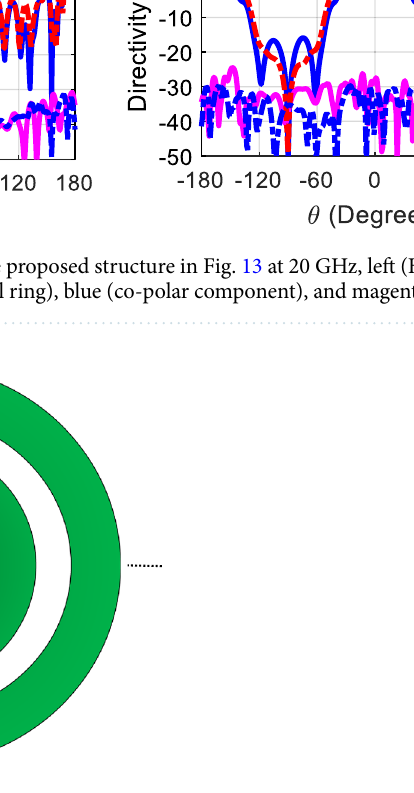
Figure 15. Two orthogonal current sources with 90° phase shift inside multiple dielectric rings